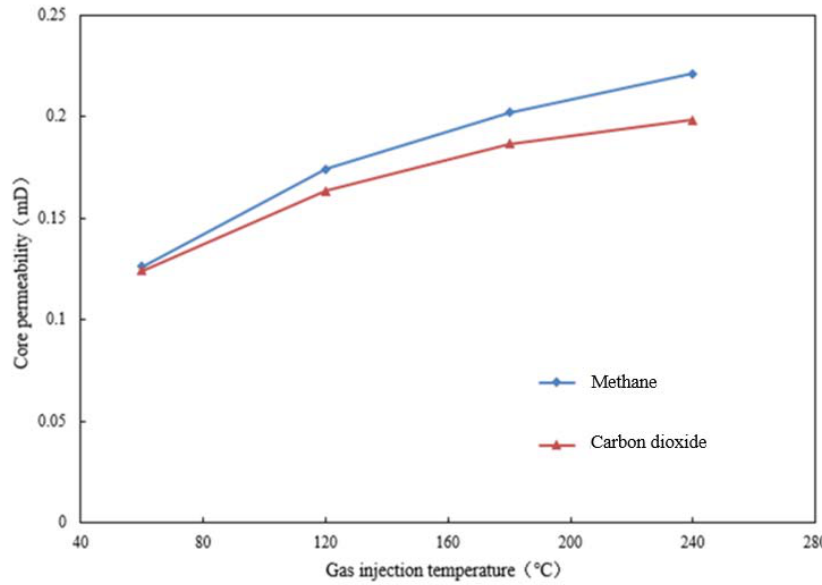
Figure 4. Relationship between gas-injection temperature and core permeability.